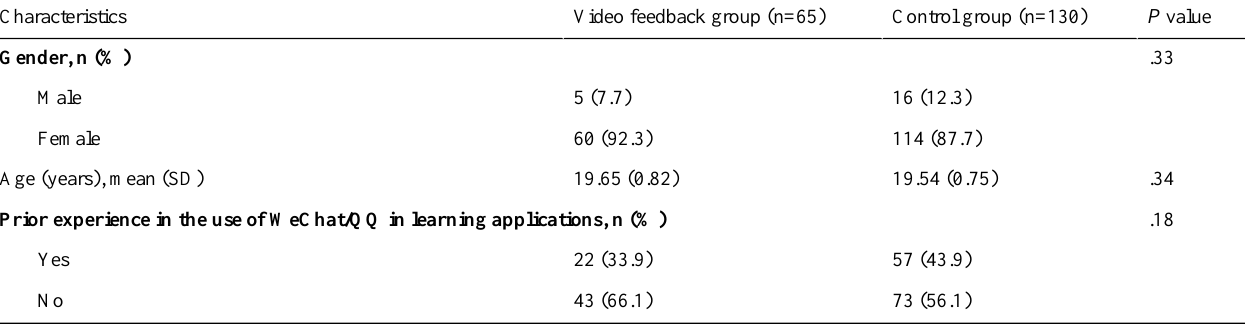
Table 1. Comparison of baseline characteristics of intervention and control groups.